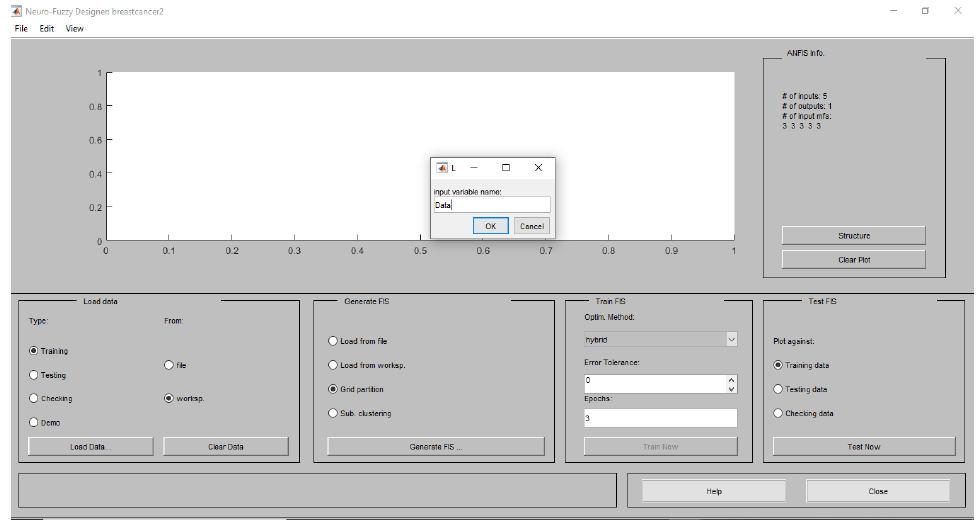
Figure 12. Loading of dataset.